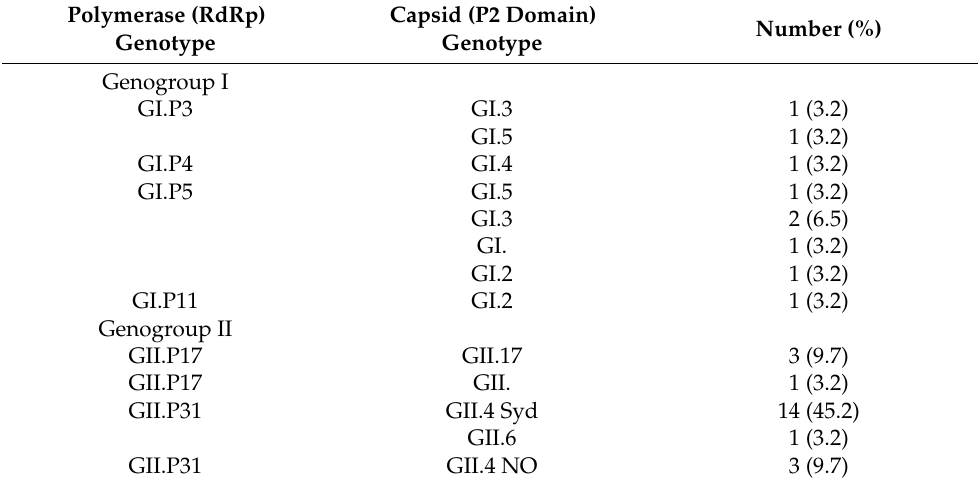
Figure 1. Seasonal distribution of enteric viruses among diarrhea cases within the sampling period, 2018–2019 . Table 3. Norovirus (NoV) polymerase and capsid genotypes obtained from the study